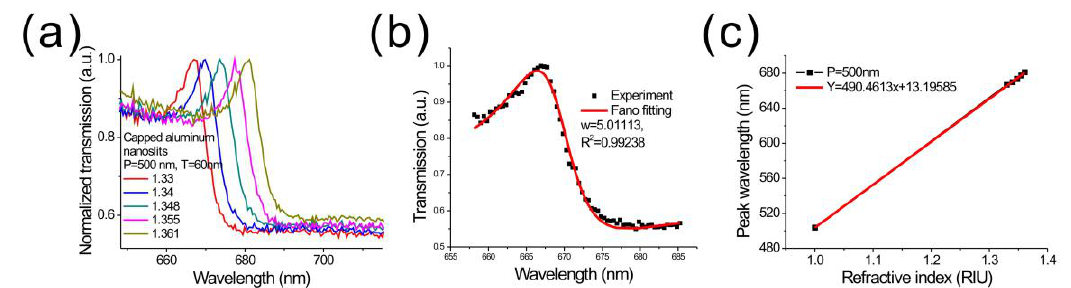
Figure 4. ( a ) The transmission spectra of the capped aluminum nanoslits with various water/glycerin mixtures. The sample was made by using dielectric-heating method; ( b ) the Breit–Wigner–Fano fitting of the Fano resonance; ( c ) the peak wavelength shift against the refractive index of medium for the nanostructure. The wavelength sensitivity was 490.46 nm/RIU.